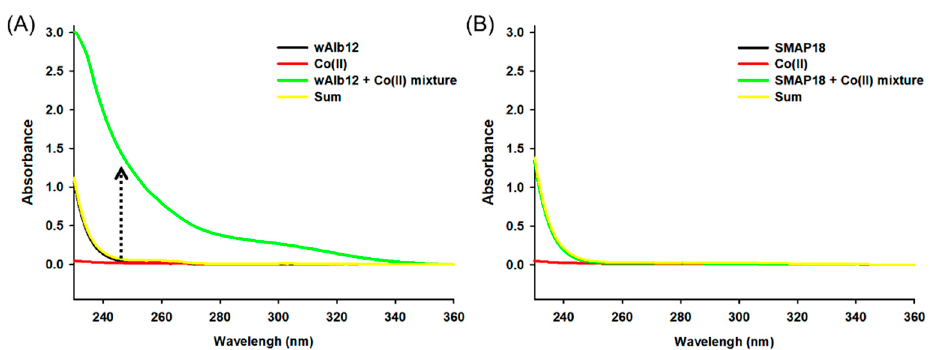
Figure 3. Change in the UV spectrum of peptides by Co(II) binding. wAlb12 ( A ) and SMAP18 (G2–G13) ( B ) at 230–360 nm.